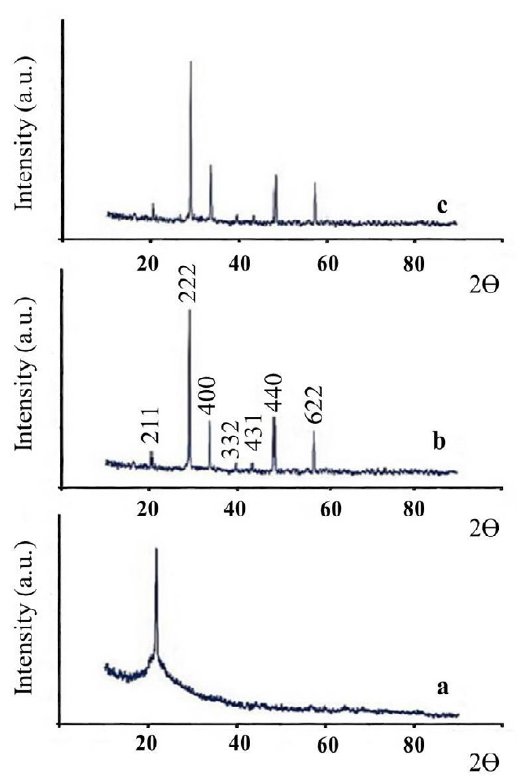
Fig.1. The XRD pattern of diatomite (a), Y Figure 1. The XRD pattern of diatomite (a), Y 2 O 3 (b) and diatom-coated with 8%- Dy doped ed with 6% Dy-doped Y Y 2 O 3 (c) nanoparticles